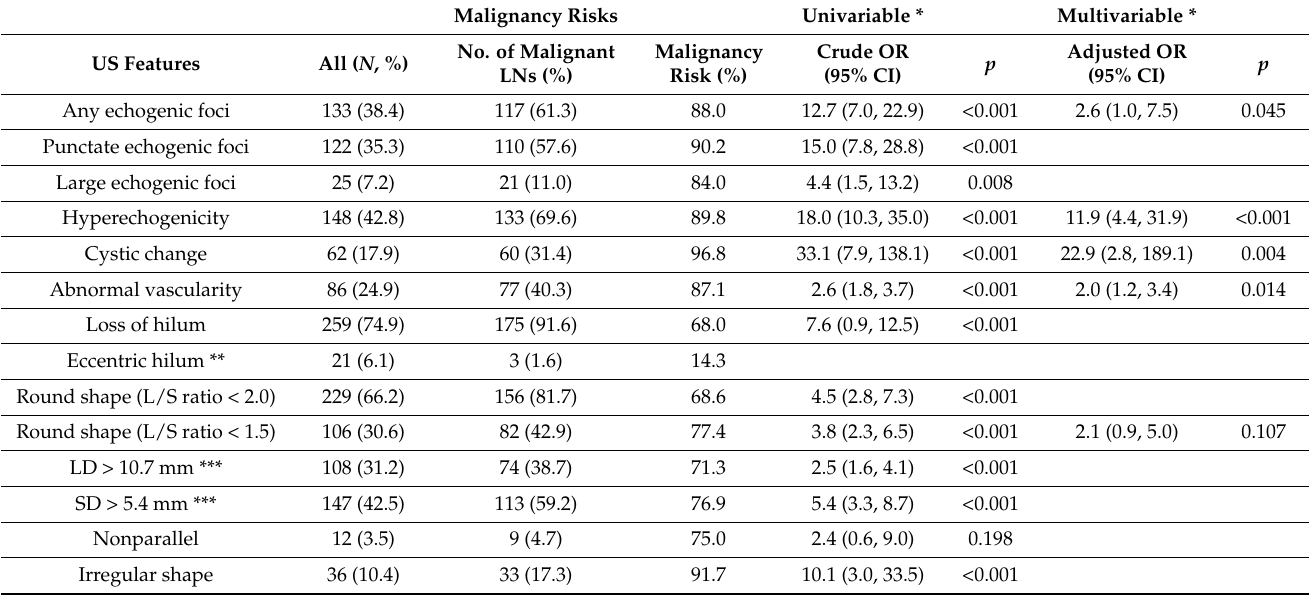
Table 2. Malignancy risk of US features and their association with